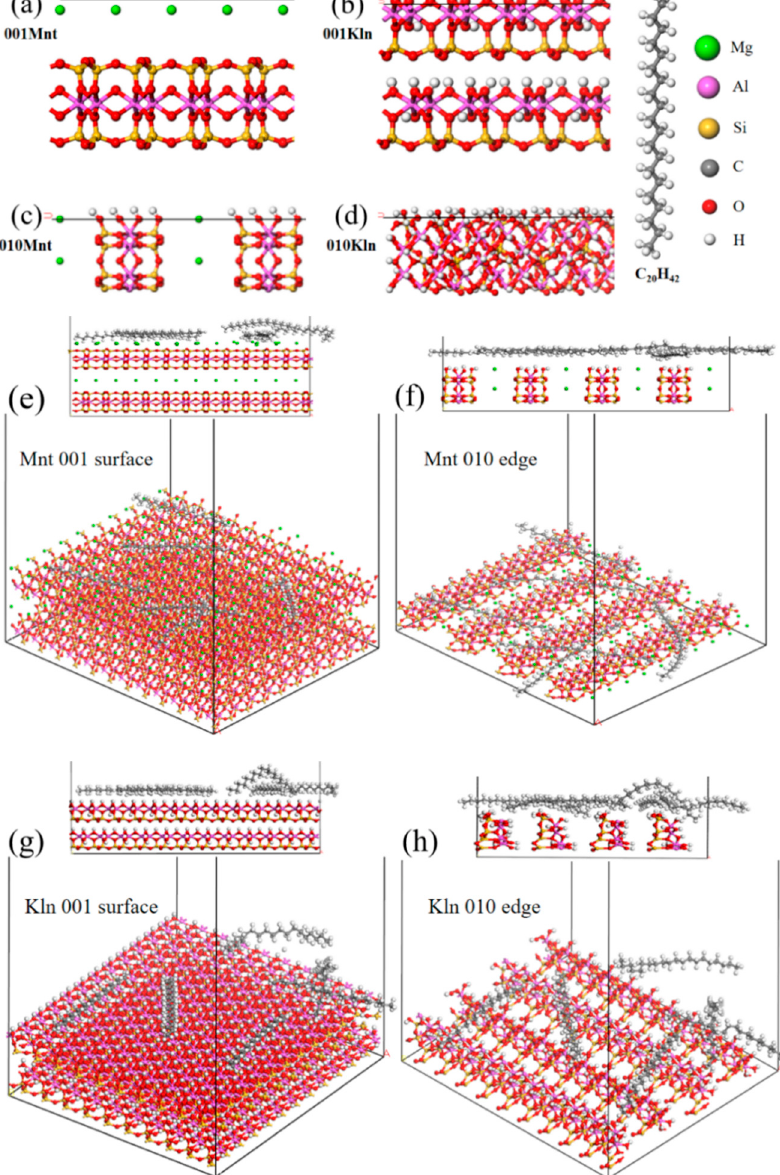
Figure 9. Molecular structures of ( a ) 001 surface and ( c ) 010 edge of Mnt, ( b ) 001 surface and ( d ) 010 edge of Kln and saturates (C 20 H 42 ), and initial configuration structures of saturates adsorbed on ( e ) 001 surface and ( f ) 010 edge of Mnt and ( g ) 001 surface and ( h ) 010 edge of Kln in 298 K.